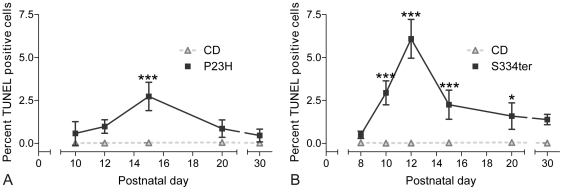
Quantification of photoreceptor cell death during the first postnatal month.(A) Increased numbers of TUNEL stained, dying cells in P23H rats, showing a peak of cell death at PN15. (B) In S334ter, TUNEL-positive cells were significantly elevated from PN10 onwards, increased in number until PN12 and decreased subsequently. In both models, dying cells were detectable as late as PN30. Values are mean ± SD from at least three different animals; *P<0.05; **P<0.01; ***P<0.001.